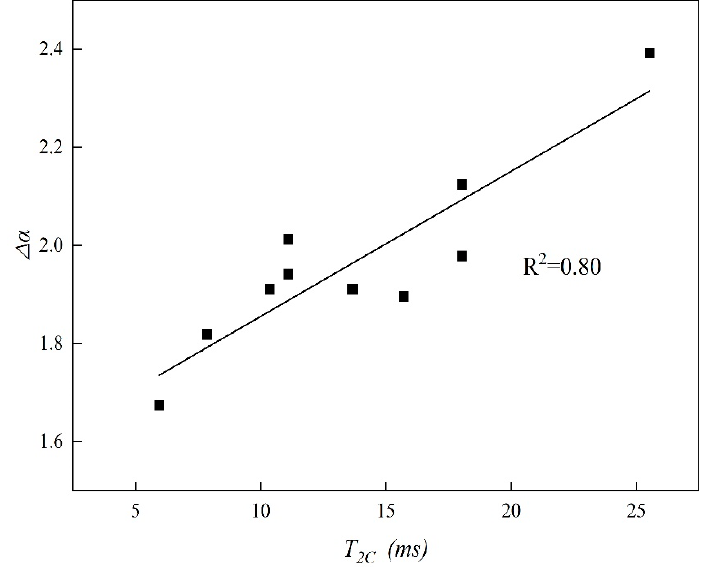
Figure 13. Relationship between T 2C and Δ α of the ten modeling samples.